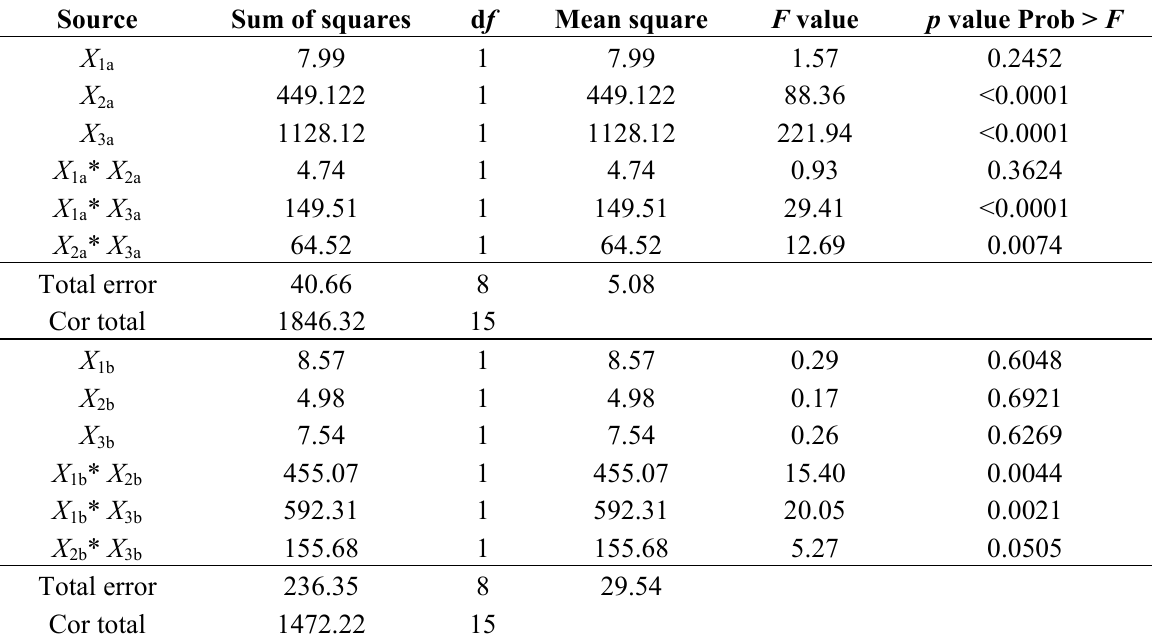
Table 3. Design matrix and response values in Plackett–Burman factorial